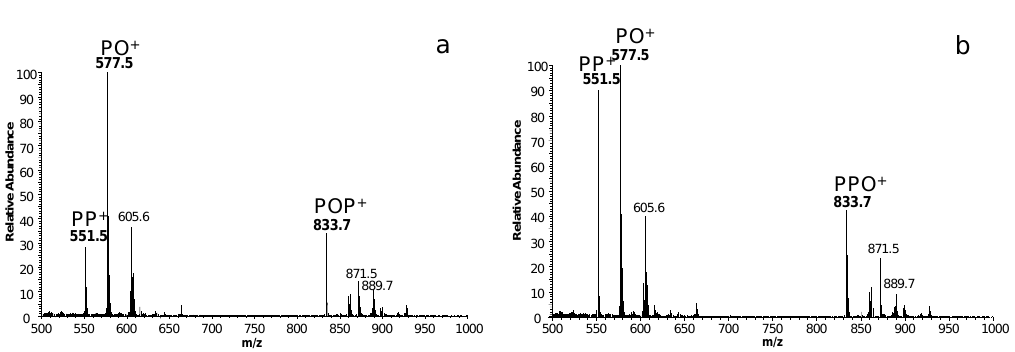
Figure 2. Full mass spectra of isobaric positional isomers POP (palmitoyl-oleoyl-palmitoyl glycerol) ( a ) and PPO (palmitoyl-palmitoyl-oleoyl glycerol) ( b ) showing the specificity of thermal fragmentation mechanism.